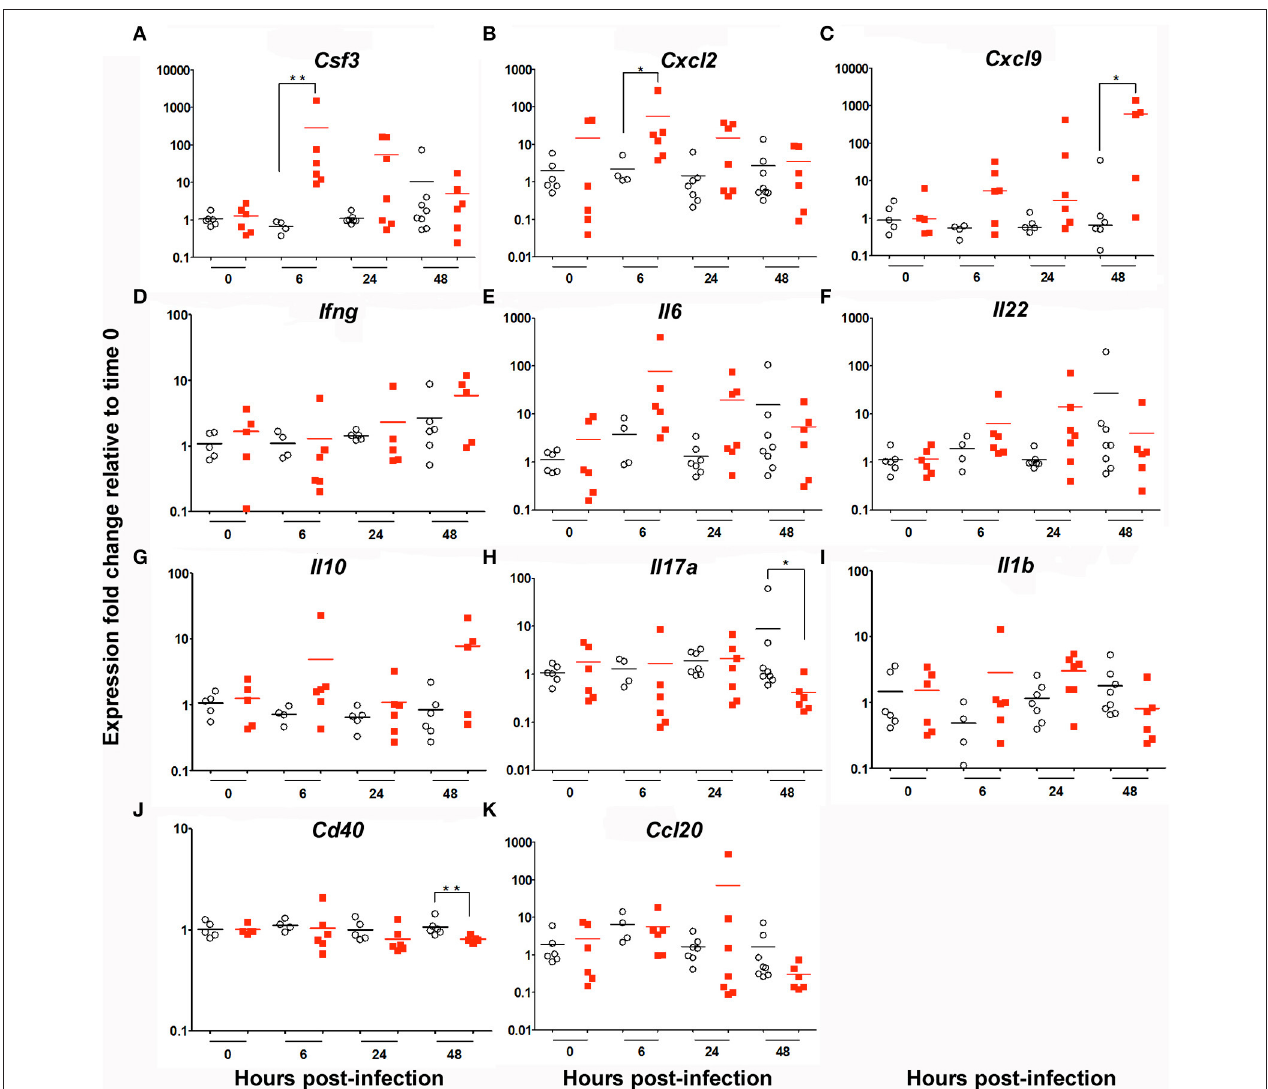
FIGURE 3 | Cytokine mRNA signature in the lung of WT and KO mice after 6, 24 and 48h infection by S. pneumonia. Messenger RNA expression of an array of cytokines, chemokines and receptors: (A) Csf3 , (B) Cxcl2 , (C) Cxcl9 , (D) Ifng , (E) Il6 , (F) Il22 , (G) Il10 , (H) , Il17a (I) Il1b , (J) Cd40 and (K) Ccl20 in the lung of WT ( ◦ ) and KO ( ) mice. Hprt was used as a house-keeping gene for analysis of Cxcl9 , Ifn γ , Il10 and Cd40 . β actin was used as a house-keeping gene for analysis of CsF3 , Cxcl2 , Il6 , Il22 , Ccl20 , Il1 β and Il17a . Results are expressed as fold-change compared to their respective mock mice and are presented as individual and mean response. N = 3-9 mice per group. * p < 0.05, ** p < 0.01 (Mann-Whitney U -test).